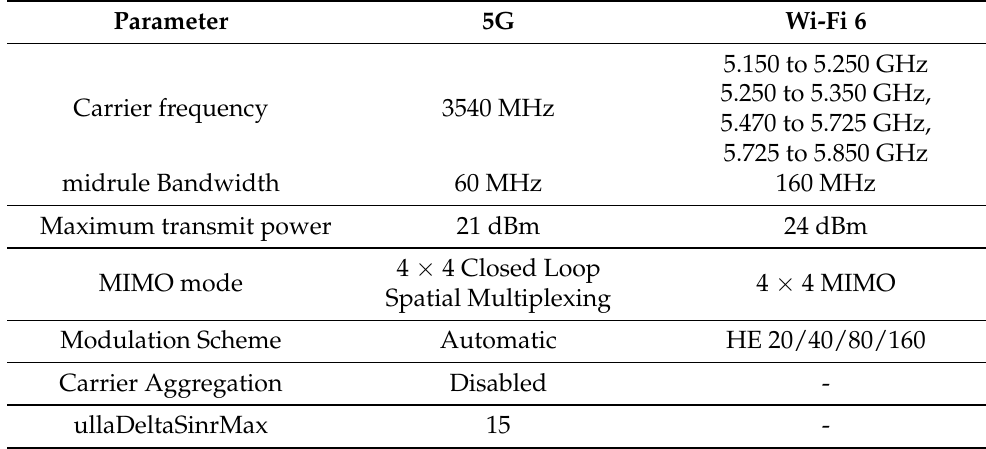
Table 2. 5G and WLAN